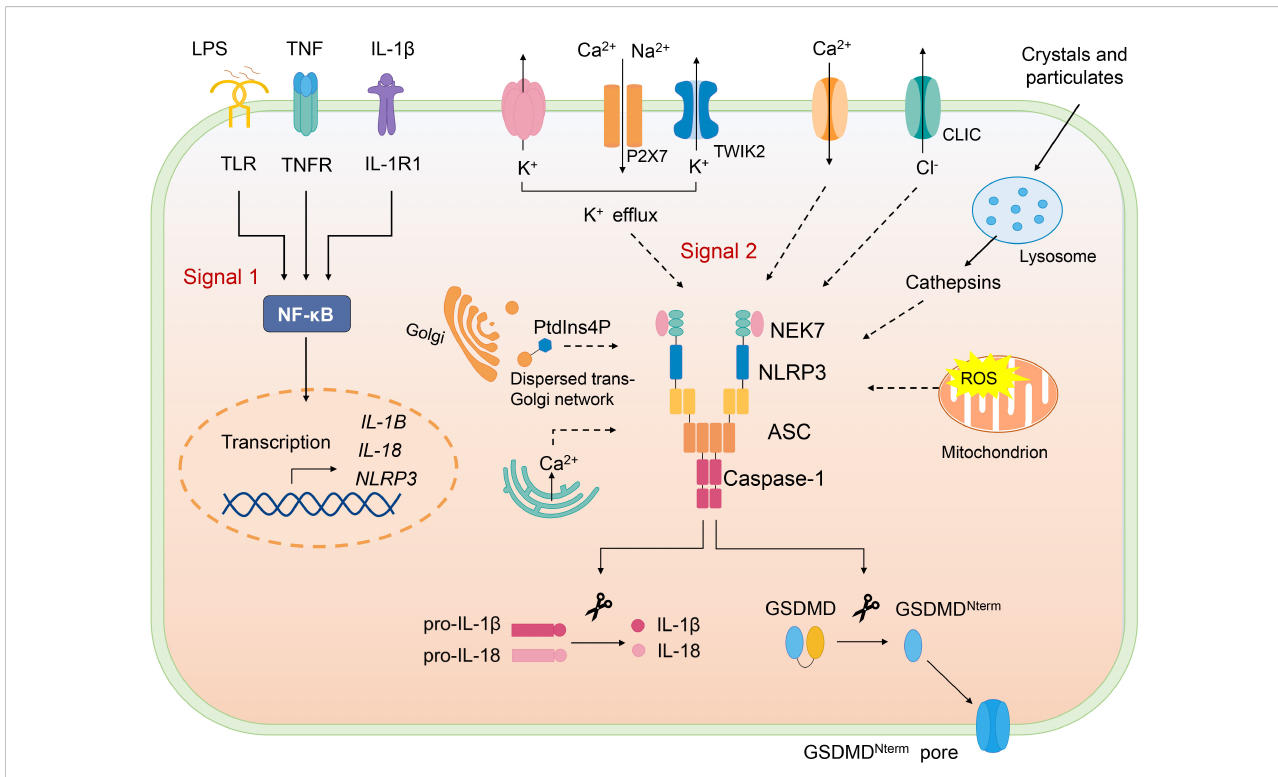
FIGURE 2 Canonical NLRP3 in fl ammasome. Canonical NLRP3 in fl ammasome activation requires two signals: The signal 1 (priming) involves PAMPs or cytokines- induced NF- k B activation and upregulates the gene expression of NLRP3 and the proin fl ammatory cytokines. Signal 2 is provided by various PAMPs and DAMPs; they activate multiple upstream signaling events, such as K + ef fl ux, Ca 2+ fl ux, Cl - ef fl ux, mtROS production, release of oxidized mitochondrial DNA, lysosome damage, and Golgi disassembly (dispersed trans-Golgi network). NLRP3 in fl ammasome assembly triggers the auto-cleavage of caspase- 1, which in turn cleaves pro – IL-1 b and pro – IL-18. Active caspase-1 also cleaves GSDMD and releases GSDMD-N from the autoinhibition and free GSDMD-N oligomerizes in membranes to form pores and induce